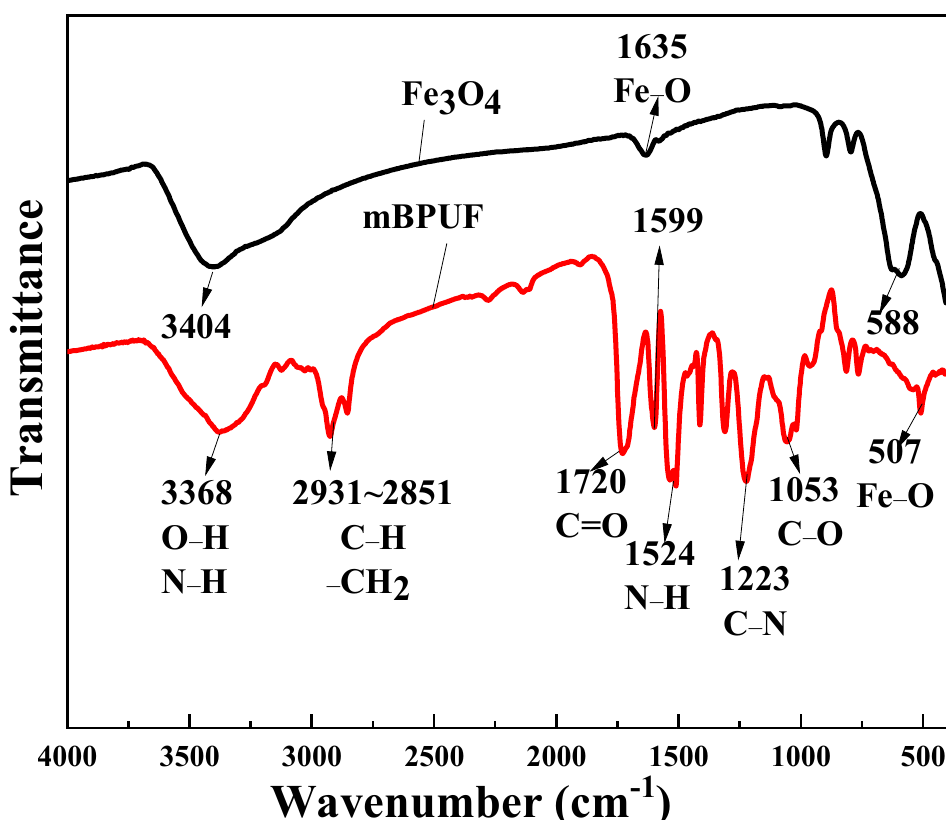
Figure 1. FTIR spectra of the Fe 3 O 4 and the mBPUF composites. The XRD patterns of Fe 3 O 4 and the mBPUF are depicted in Figure 2. The Fe 3 O 4 na- noparticles in Figure 1 exhibit sharp peaks, which are located at 30.8° (220), 35.5° (311), 36.9° (222), 42° (331), 43.2° (400), 45.9° (331), 53.6° (422), 57.7° (511), and 64° (440) [19,20]. For the mBPUF, the majority of the diffraction peaks for Fe 3 O 4 are presented, but the in- tensity of the peaks is weak. This indicates that part of the magnetic absorbents is em- bedded in the porous resin, which influences the crystalline structure. One reason is that Fe 3 O 4 particles are masked and cannot be detected in the porous resin matrix. The other reason is that the molecular interaction between the Fe 3 O 4 particles and BPUF matrix may result in a slight shift in diffraction angle and the difference in the crystalline size. The peak at 22° of the mBPUF is associated with the base polymer. The presence of the macromolecule shell, which wraps the Fe 3 O 4 particles and changes the chain’s conforma- tional restrictions [21].